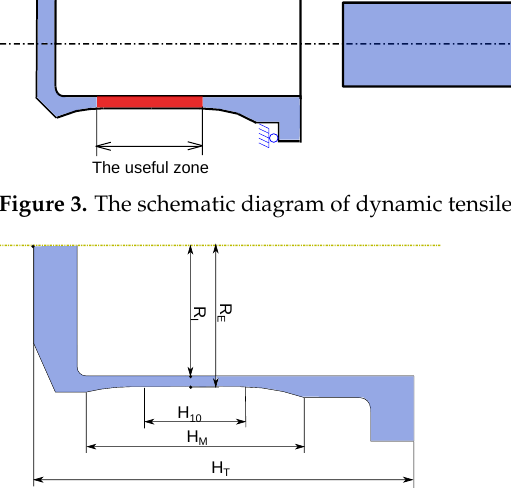
Figure 4. Dimensions to be measured for the dynamic tensile test.